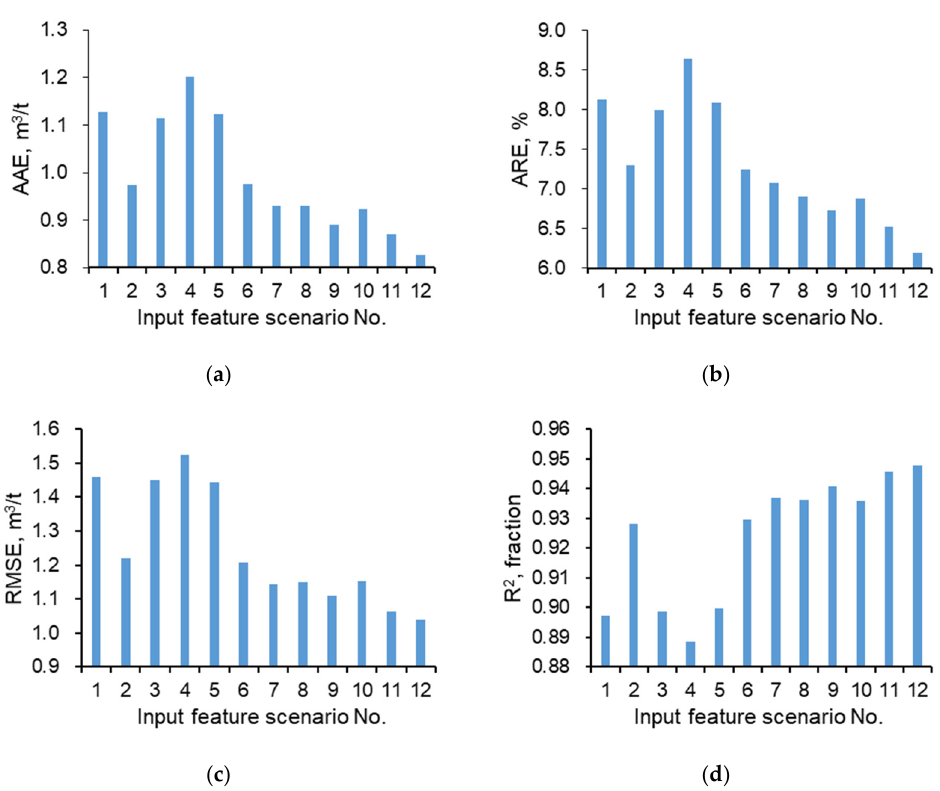
Figure 13. Error matrices of ( a ) average absolute error (AAE), ( b ) average relative error (ARE), ( c ) root mean squared error (RMSE) and ( d ) R 2 for different input feature scenarios.